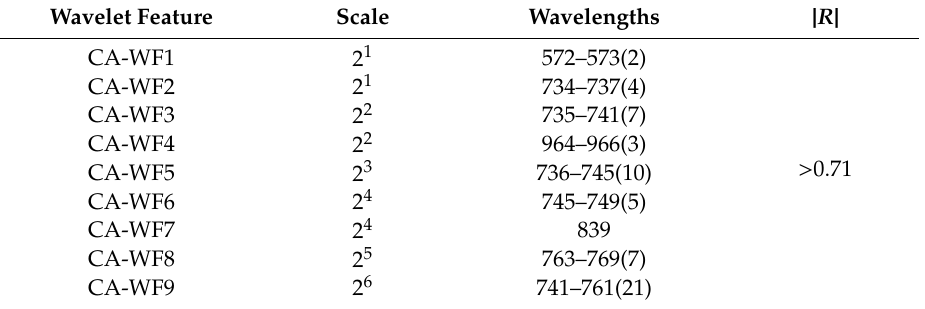
Table 4. The information of wavelet features selected using correlation